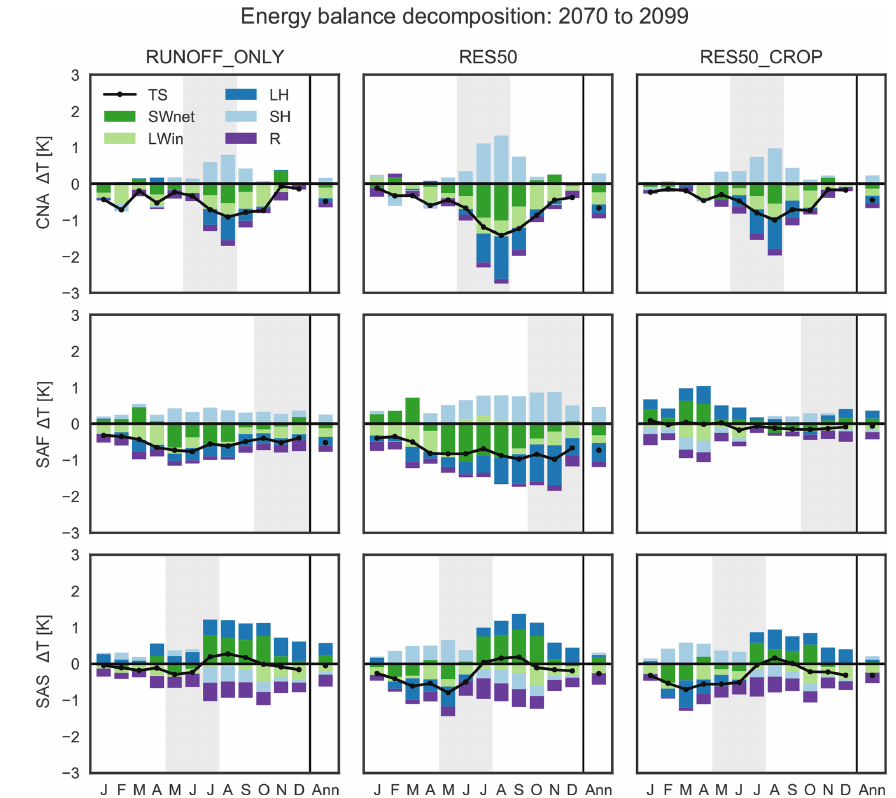
Figure 5. The seasonal cycle and annual mean (Ann) of surface temperature anomalies and energy balance decomposition for central North America (CNA), South Asia (SAS), and South Africa (SAF). Grey shading indicates the warm season. TS stands for surface temperature, SWnet denotes net short-wave radiation; LWin denotes incoming (downward) long-wave radiation; LH and SH denote the latent and sensible head flux, respectively; and R is the residual term, which includes the ground heat